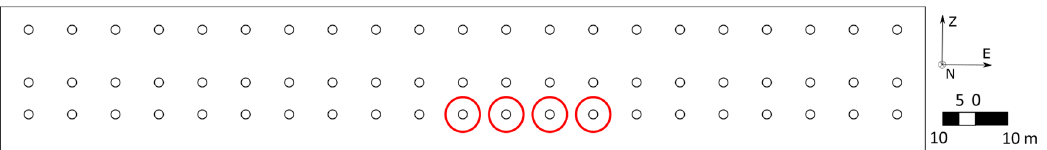
Figure 2. Scheme of Ground Control Points (GCPs) locations on the upstream face of the dam. The red circles show the position of the four GCPs used to retrieve the water level from the images.